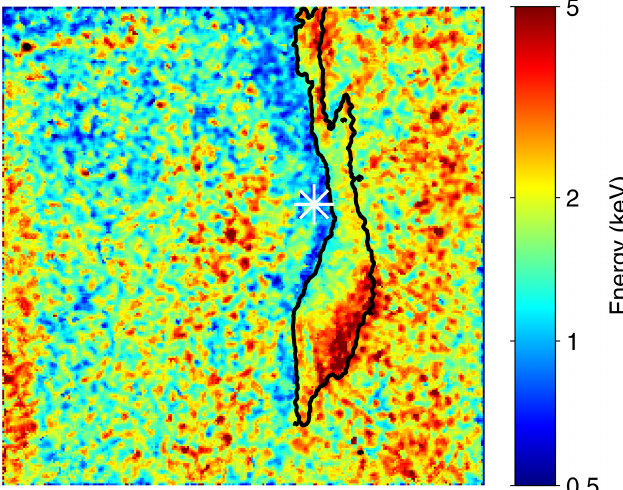
Figure 5. Perspective-corrected estimate of energy across the ASK field of view. The white asterisk indicates the position of the mag- netic